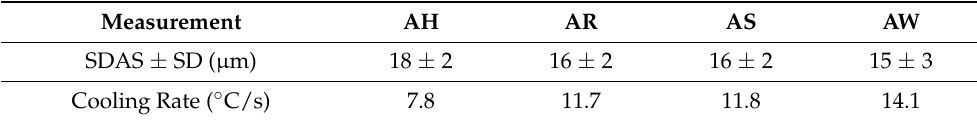
Table 2. Summary of the grain size, secondary dendrite arm spacing (SDAS) and cooling rate for the as-cast